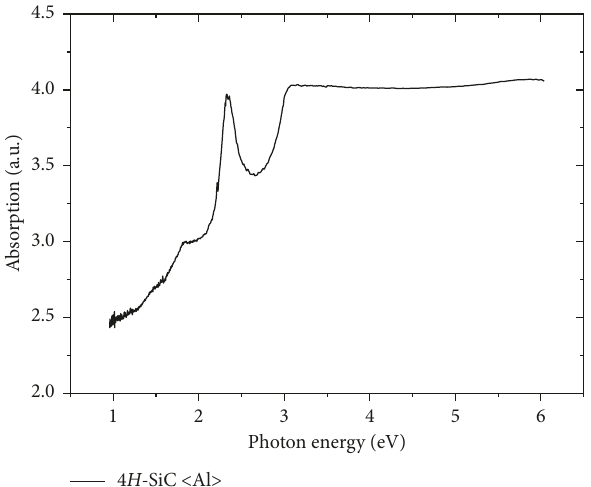
Figure 5: Spectrum of optical absorption of p-n -4 H -SiC structures doped with aluminum (from a source created from a thin alu- minum film sputtered in